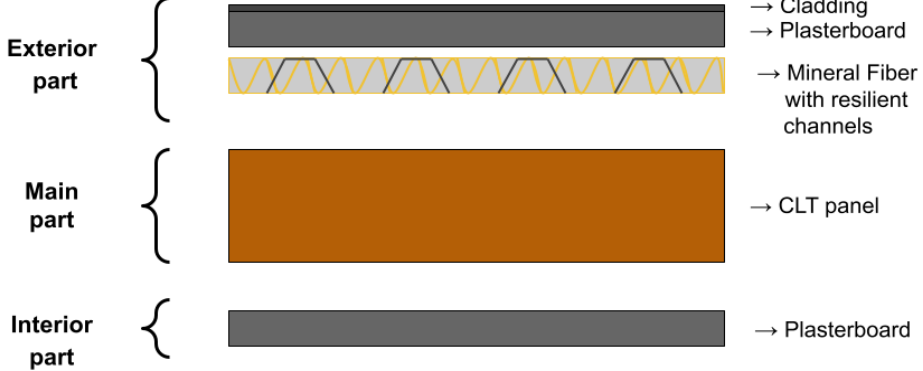
Figure 2. An explanation schematic presenting how façade components are clustered in the database using an example of the test façade #6.